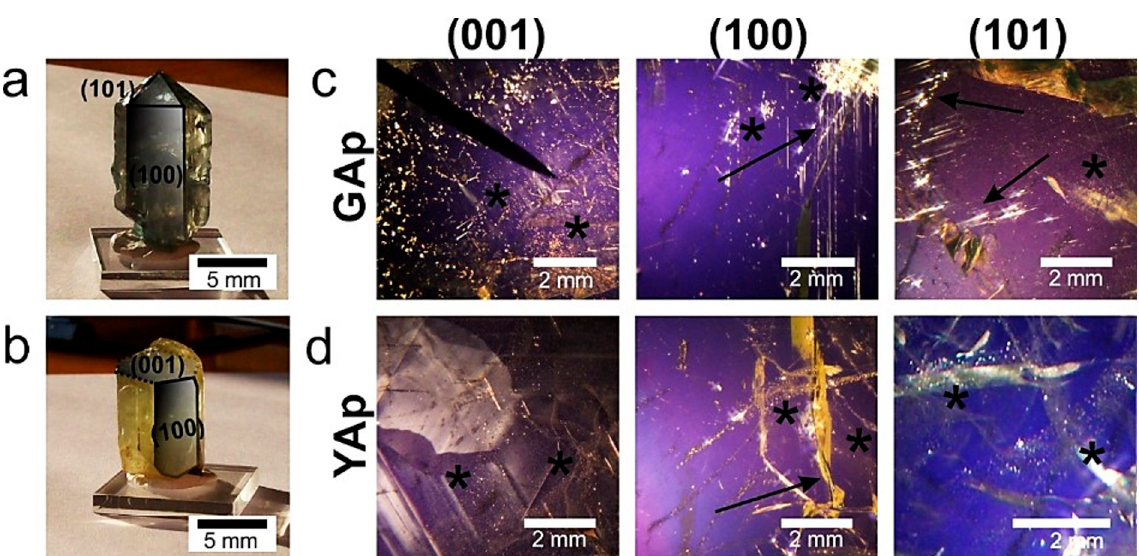
Figure A1. The single crystals of natural mineral apatites GAp ( a ) and YAp ( b ), with well-developed crystal faces corresponding to the (100) and (101) faces marked with continuous lines. The (001) cut of the crystal, shown in ( b ), is marked with broken lines. ( c ) The GAp (001), (100) and (101) plates are shown in polarized light. The inclusions are seen as illuminated irregularly-shaped points of variable diameters. The accumulations of tiny (‘foggy’) inclusions and the longitudinal-shaped ones (paralleled to c-axis) are marked with asterisks and arrows, respectively. The YAp plates are shown in polarized light ( d ). The inclusions are seen as bright, bubble-like points arranged in bands (marked with asterisks). The arrow indicates fracture in the fragment of (100)